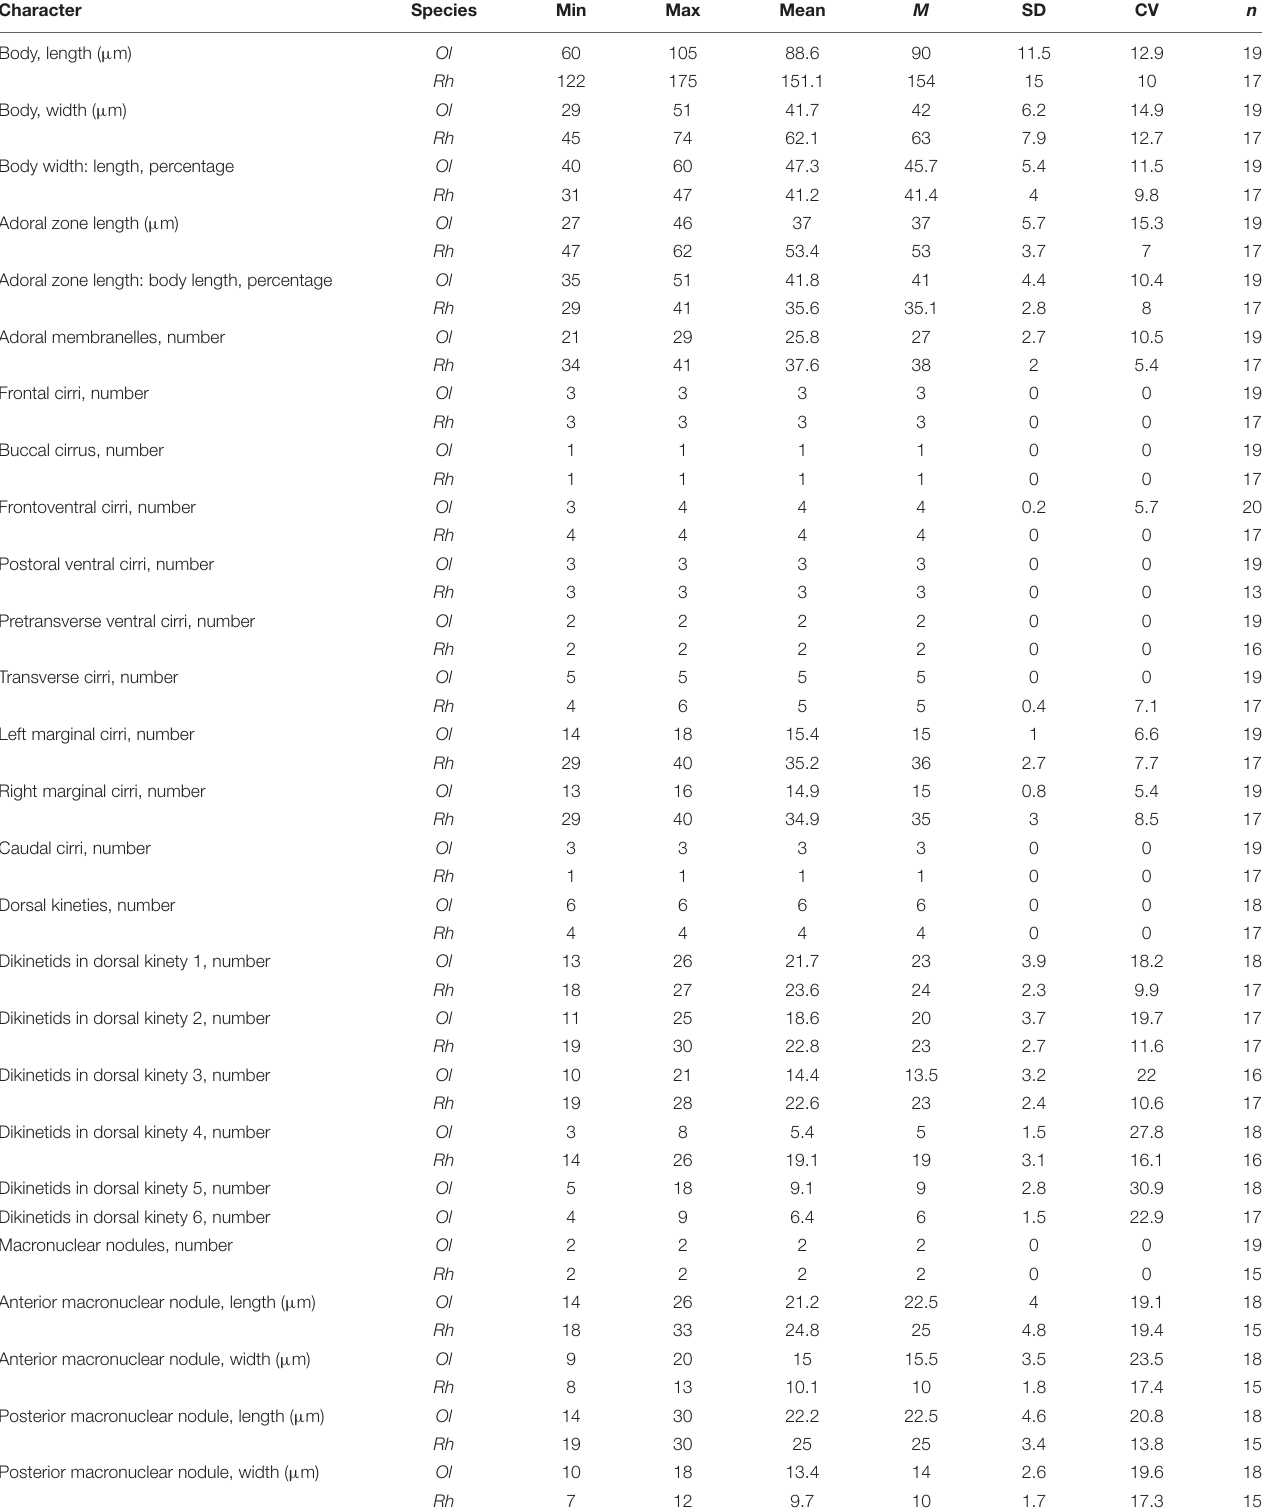
TABLE 1 | Morphometric data of the Chinese populations of Oxytricha lithofera ( Ol ) and Rubrioxytricha haematoplasma ( Rh ) based on protargol-stained specimens. Character